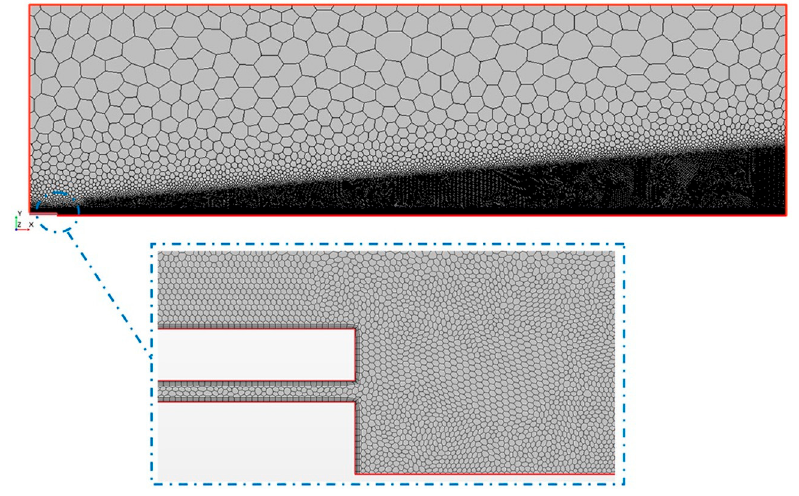
Figure 6. Discretised representation of the computational